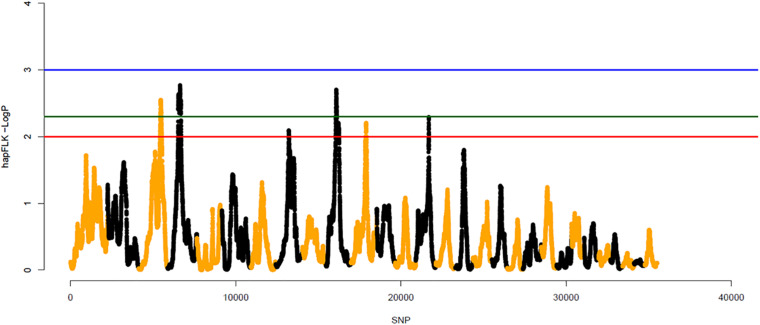
Whole genome scans for signatures of selection using the haplotype based hapFLK metric considering 32 cattle breeds and Yak as outgroup (first scenario). Odd and even numbered chromosomes are shown in yellow and black, respectively. SNP number is given on the x-axis, and the genome-wide threshold corresponding to P < 0.001, P < 0.005, and P < 0.01 is shown as horizontal blue, green and red lines, respectively.